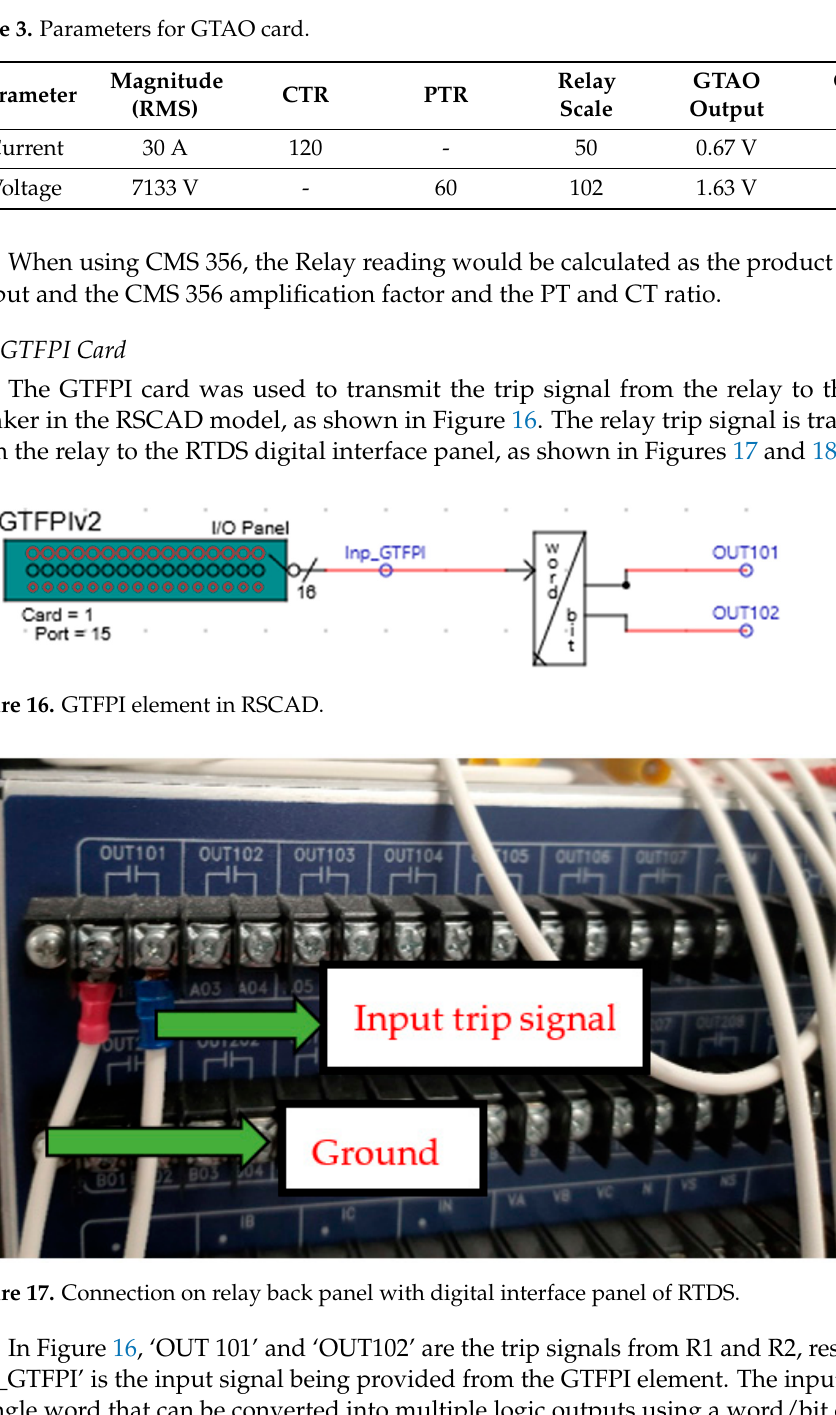
Figure 18. Digital interface panel of RTDS receiving signal from relay. The connections coming from ‘OUT 101 ′ shown in Figure 17 were provided to the digital interface panel, as shown in Figure 18. As mentioned previously, two ports of the panel were used, i.e., one for relay R1 and one for relay R2. The input trip signal coming from relay was connected to the digital input channel on the panel, and the ground signal coming from relay was connected to the ground input on the panel. 5.4. Applying Faults to the System Figure 19 shows the fault logic developed in RSCAD for the system. ‘SW1 ′ , ‘SW2 ′ , and ‘SW3 ′ were the switch elements in RSCAD, which denoted phases of the system. Each switch needed to be turned on to introduce the fault on the corresponding phase. For ex- ample, to apply a three-phase fault, all three switches must be turned on. Each fault type in RSCAD was assigned a binary value, which had a corresponding decimal value, as